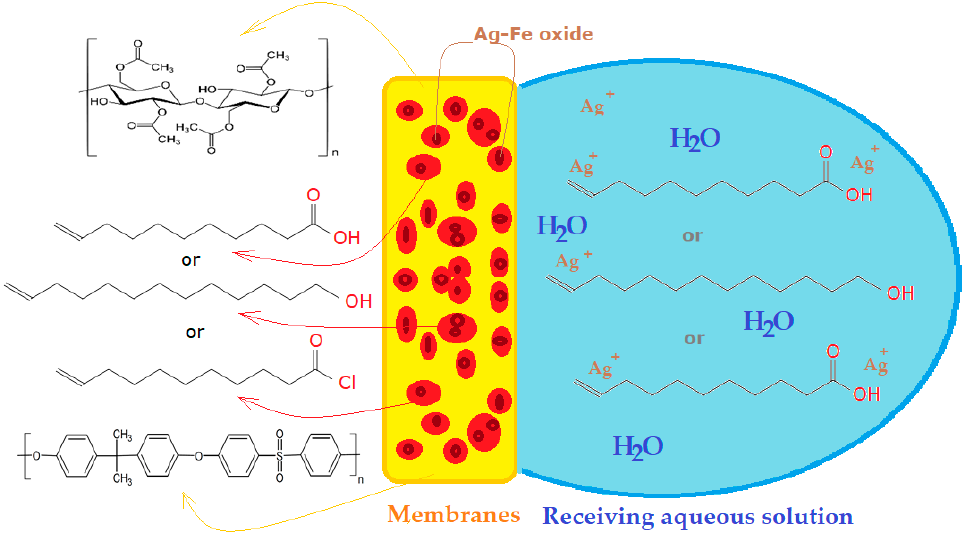
Figure 5. Schematic representation of the system of releasing silver ions and 10–undecenoic acid from the impregnated polymer membrane in an aqueous solution.